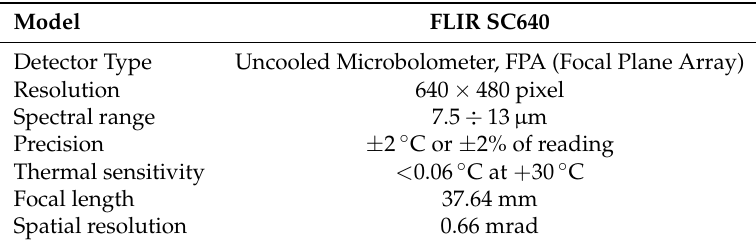
Table 1. Main characteristics of the thermal